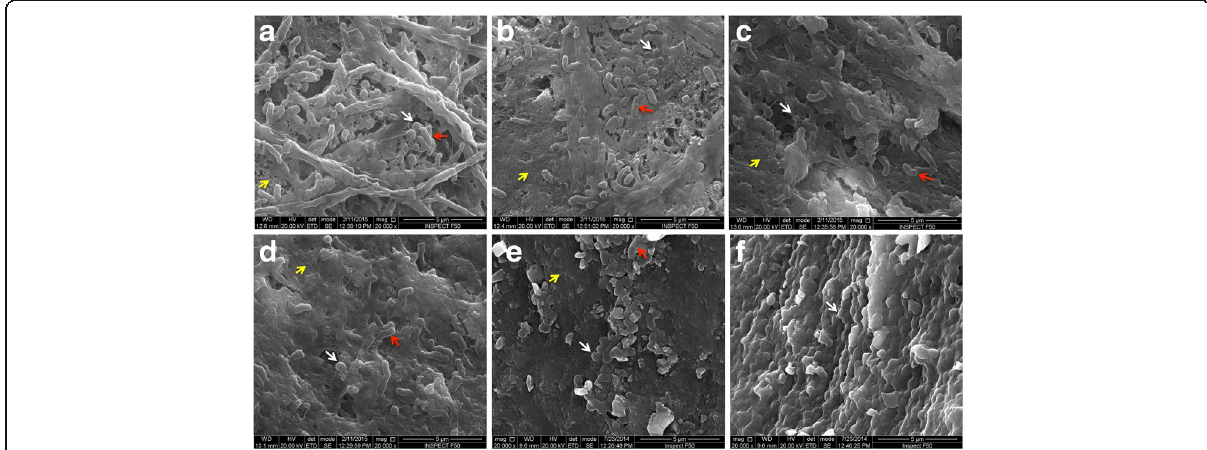
Fig. 2 Bacteria on enamelo-cemental junction of rats ’ teeth detected by scanning electron microscopy. a : P. gingivalis W83 alone; b : P. gingivalis W83 plus 6.25 μ g/mL of Nal-P-113; c : P. gingivalis W83 plus 25 μ g/mL of Nal-P-113; d : P. gingivalis W83 plus 100 μ g/mL of Nal-P-113; e : P. gingivalis W83 plus 400 μ g/mL of Nal-P-113; f : control group, without P. gingivalis W83 or Nal-P-113. SEM magnification, 20,000×. Red arrows indicate P. gingivalis W83; white arrows indicate Coccus , a genus of resident bacteria in the rat oral cavity; yellow arrows indicate the rat tooth